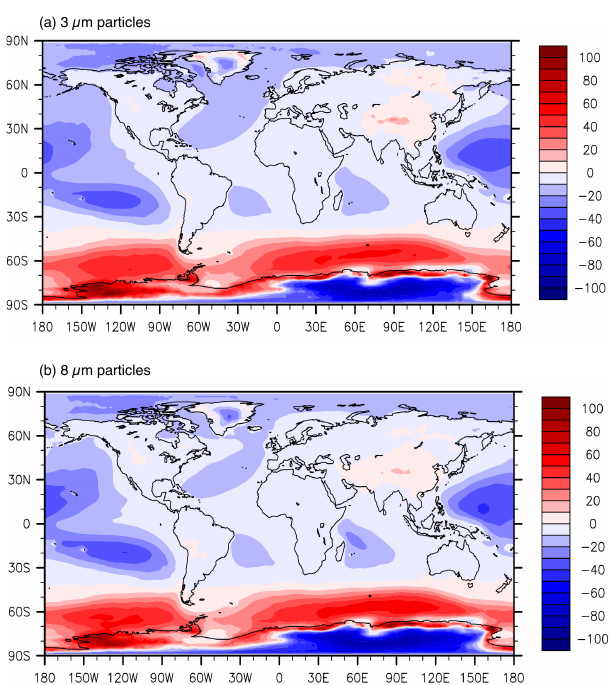
Figure 7. Global model results showing percentage change between IN-Active and IN-Inactive EMAC simulations in surface annual mean concentration, with percentage change being calculated as (IN-Active–IN-Inactive)/IN-Inactive × 100%. (a) 3µm particles; (b) 8µm particles. In all simulations, spores are assumed to be CCN active. IN-Active assumes that particles are removed by ice-phase nucleation at temperatures at and below − 25 ◦ C and above − 35 ◦ C. Constant emissions were simulated from land surfaces, except for land covered with ice.